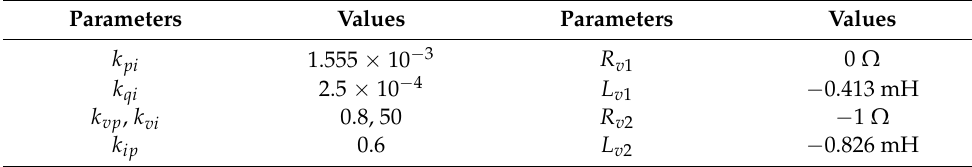
Table 2. Simulation Parameters of Traditional Virtual Impedance Droop Control.